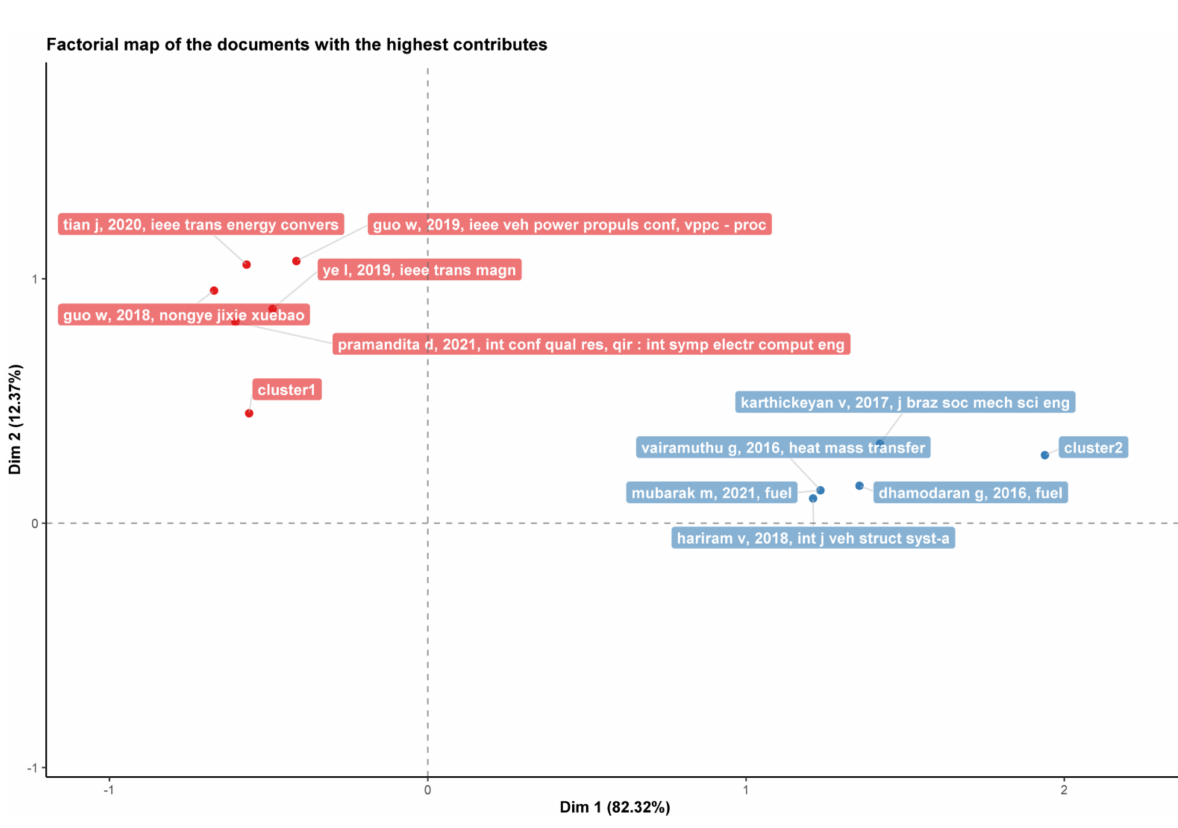
Figure 14. Factorial map of the documents with the highest contributes.